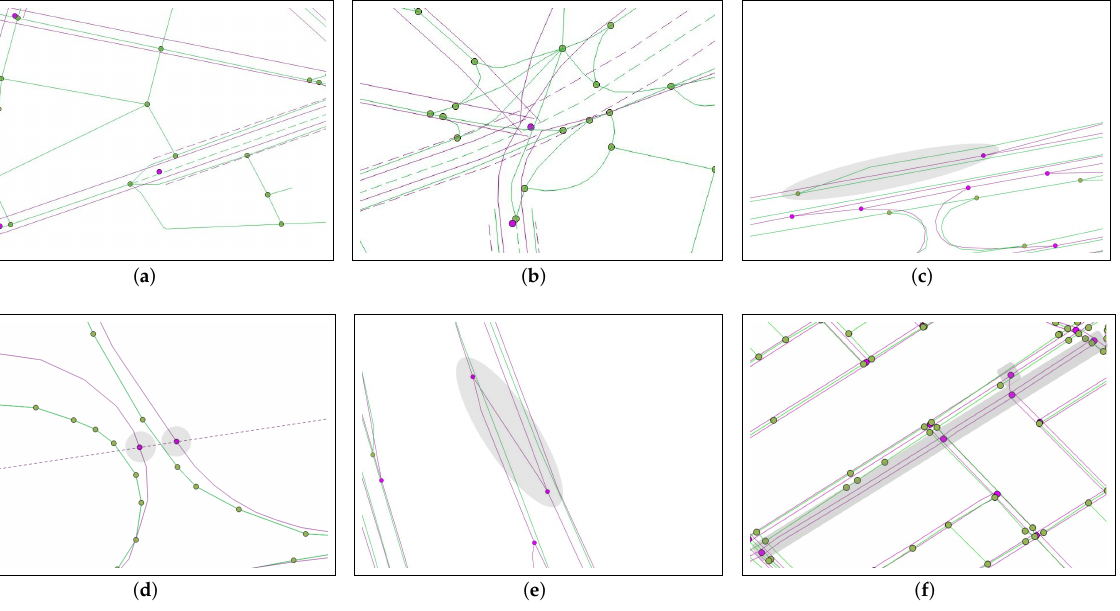
Figure 4. Examples of the representational dissimilarities between NLM and ORN: ( a ) Number of road objects, ( b ) LoD difference at complex intersection, ( c ) different rules to represent merging lane, ( d ) no corresponding ORN nodes, ( e ) no corresponding ORN edge, and ( f ) no corresponding ORN